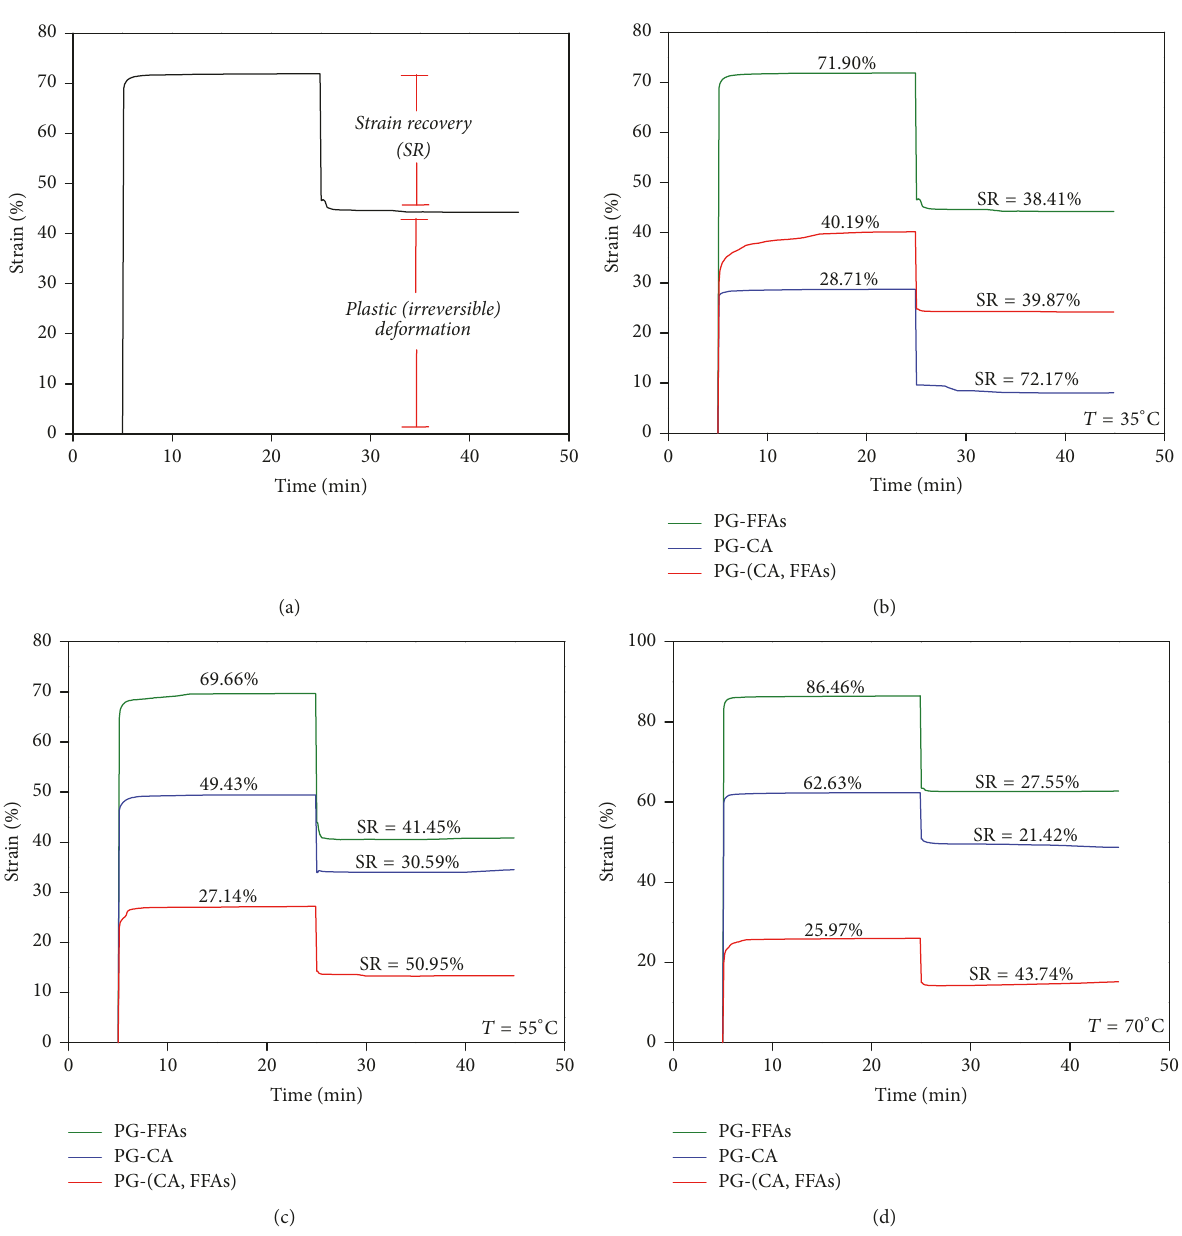
chain size, its crosslinking degree is low holding limited water molecules within its